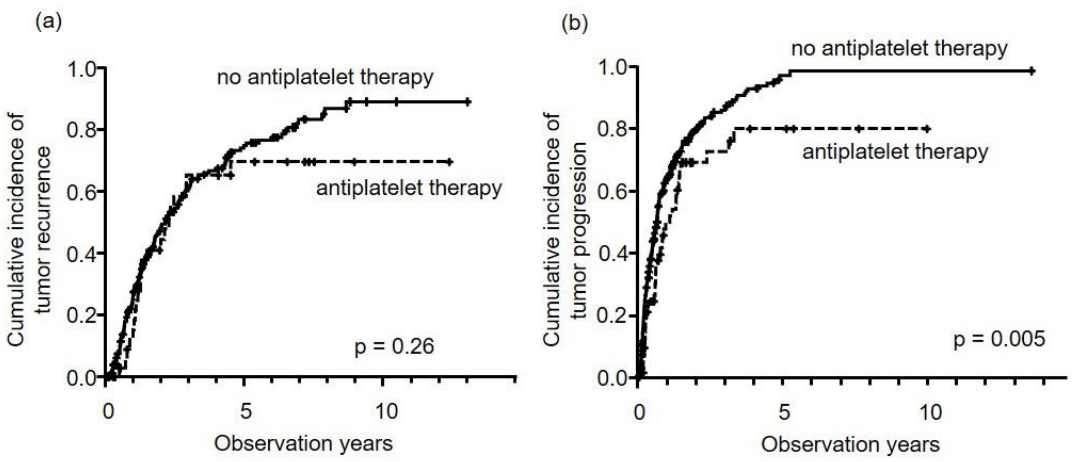
Figure 1. Overall survival and cumulative incidence of liver-related deaths in HCC patients who did or did not undertake antiplatelet therapy. ( a ) Five-year overall survival rates for antiplatelet therapy (dotted line) and no antiplatelet therapy (solid line) were 59.0% and 33.5%, respectively. Antiplatelet therapy resulted in significantly better prognoses (log-rank test; p < 0.001). ( b ) Five-year cumulative incidence rates of liver-related deaths with antiplatelet therapy (dotted line) and no antiplatelet therapy (solid line) were 36.1 and 62.4%, respectively. Antiplatelet therapy resulted in significantly better prognoses (log-rank test; p < 0.001).